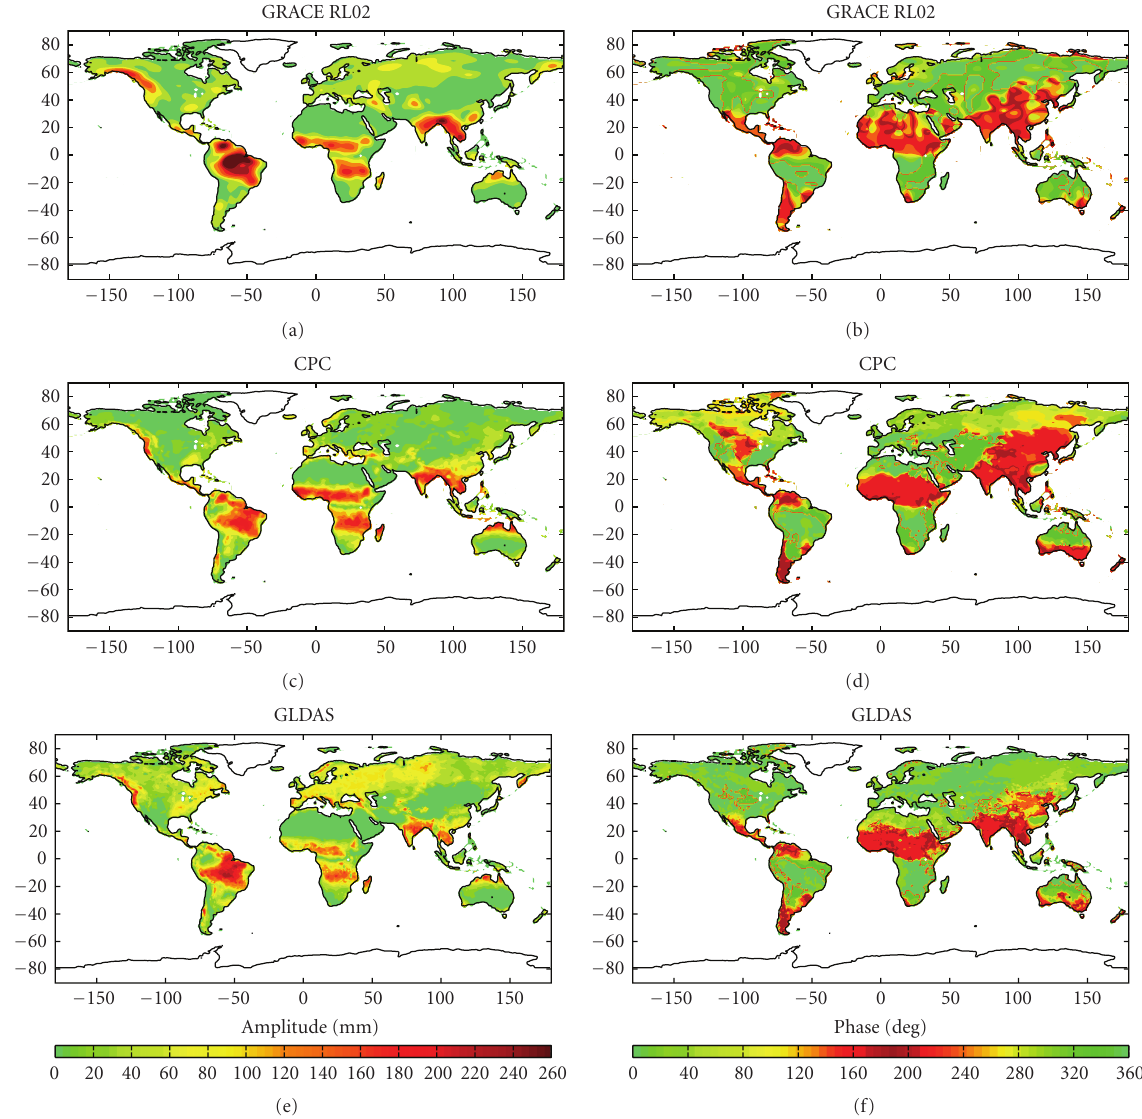
Figure 4: Amplitudes (left column) and phases (right column) of annual oscillations at every grid point computed from GRACE solutions and CPC and GLDAS models. The reference date for the phase is 2004 January 1, 0h UTC. The prominent annual signal are located in the monsoon